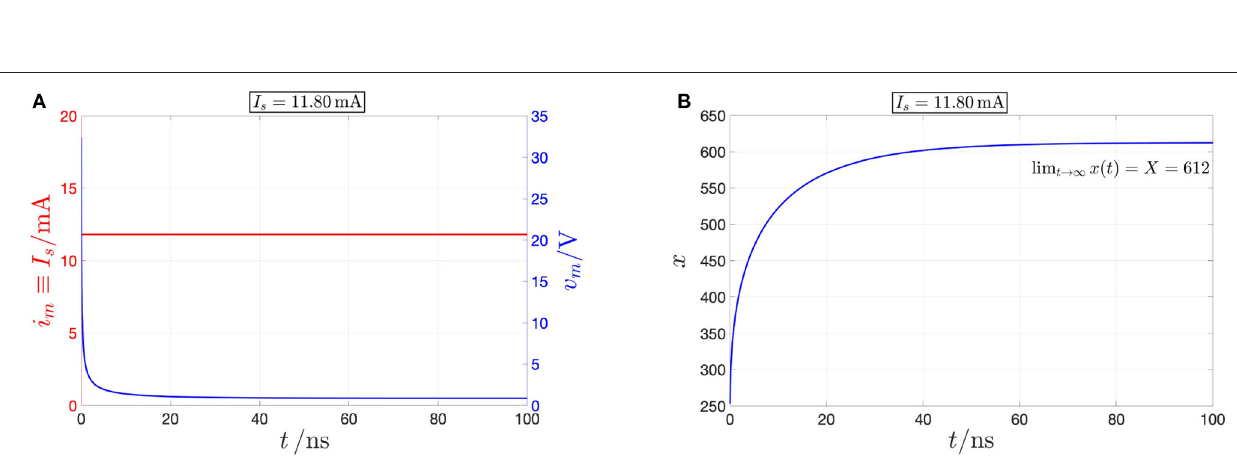
FIGURE 7 | Model numerical simulation demonstrating the inherently stable nature of the NDR operating point Q m control. A DC source of current I s 11.80mA, shown through the red color in (A) , is applied directly across the NbO threshold switch. The resulting time waveforms = of memristor voltage [in blue in (A) ] and state [in blue in (B) ] approach asymptotically the DC values V m was arbitrarily chosen as